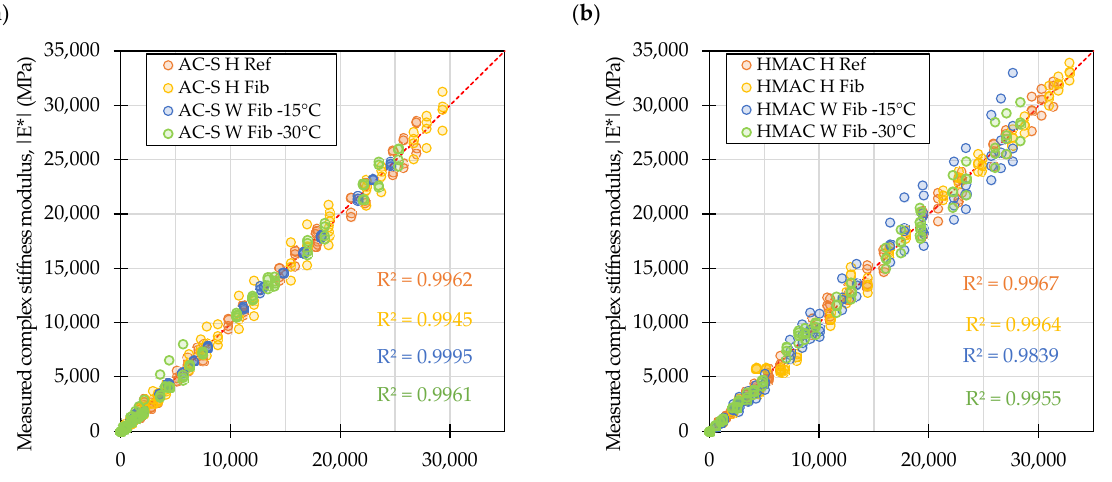
Figure 4. Complex stiffness modulus master curves characterizing the evaluated mixtures produced in laboratory: Surface course mixtures ( a ) and high modulus mixtures ( b ).